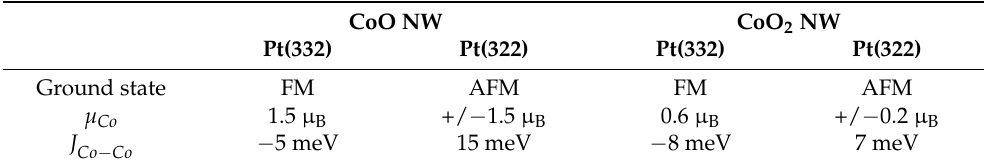
Table 1. Magnetic moment ( µ Co ) and exchange parameter ( J exchange channels